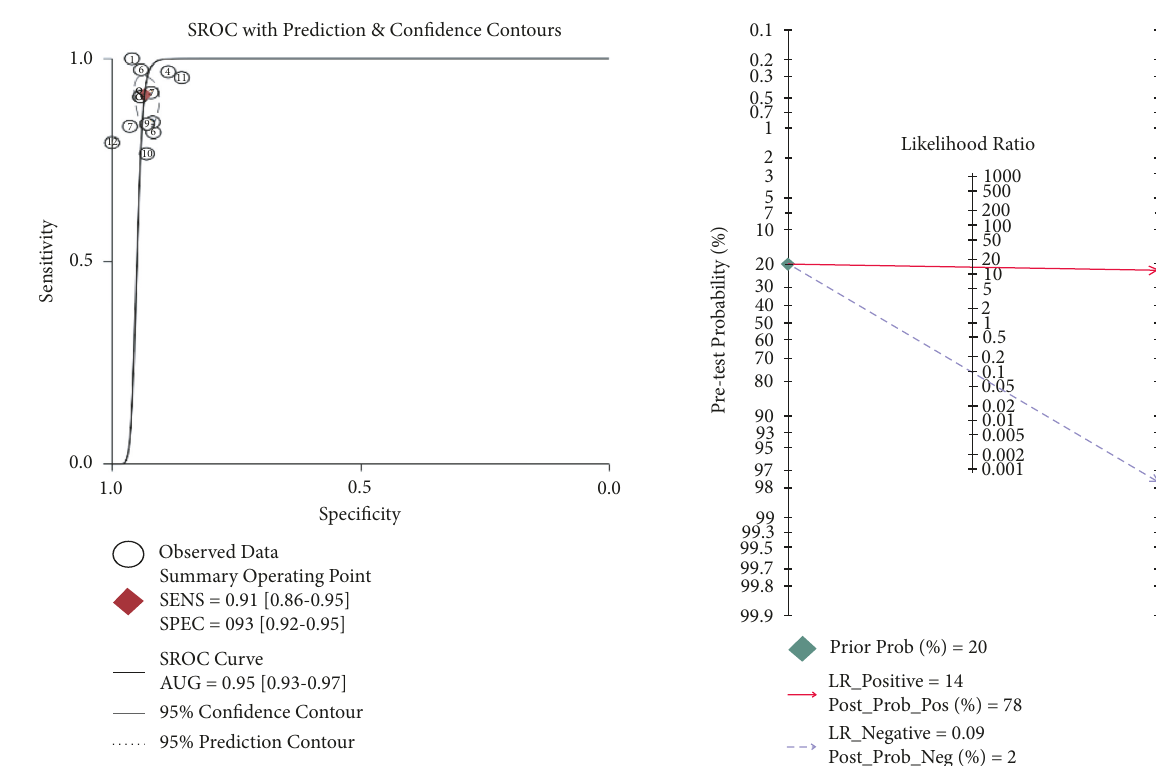
Figure 4: The summary receiver operating characteristic (SROC) curve and the area under the curve (AUC). The AUC was 0.95 (95% CI: 0.93–0.97). AUC, area under the curve; SENS, sensitivity; SPEC, specificity.